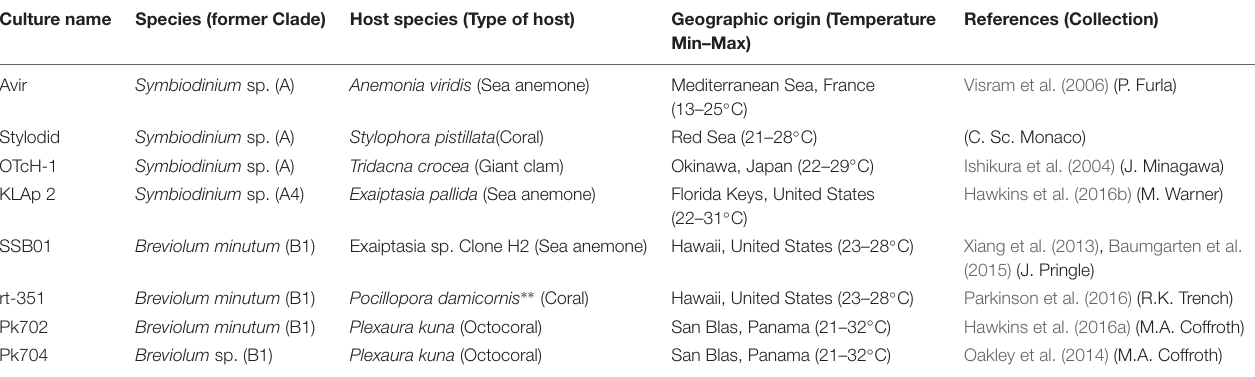
TABLE 1 | Symbiodiniaceae strains used in this